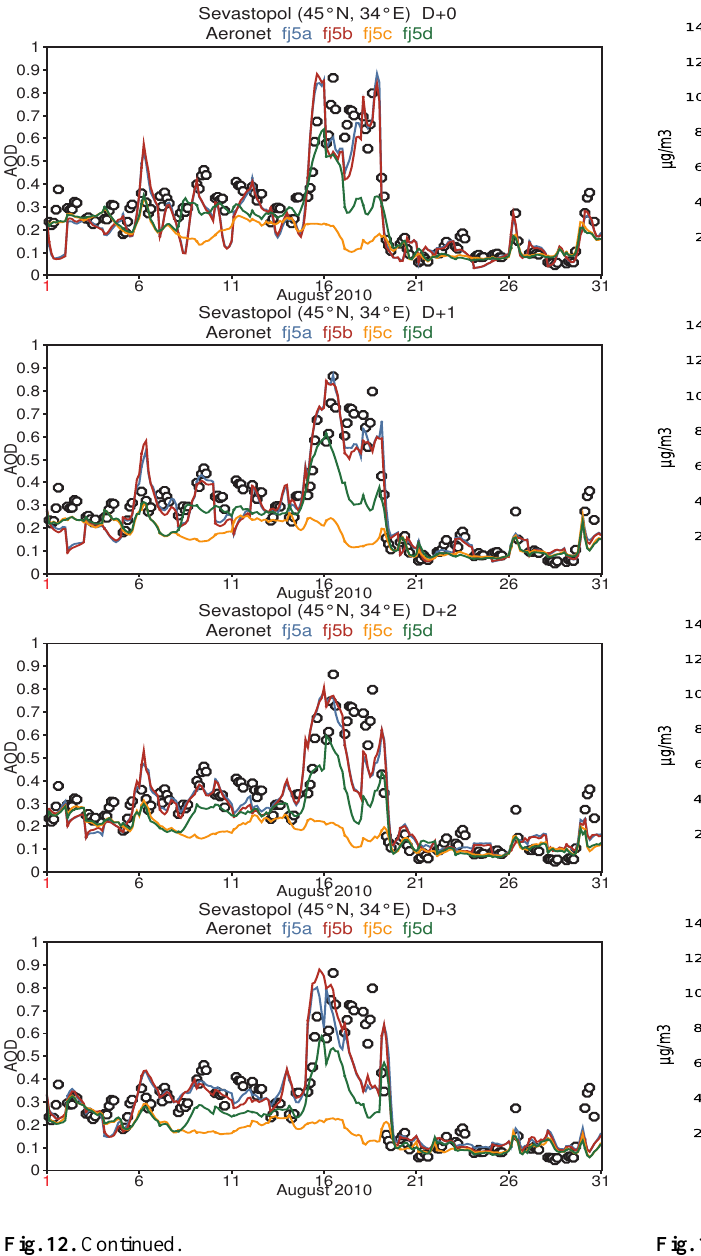
corrected by assuming the same FRP areal density through- out the grid cell. Observation gaps are further filled with a Kalman filter and a system model that assumes persis- tence of FRP. The strongest spurious FRP signals from vol- canoes, gas flaring and industrial activity are masked,